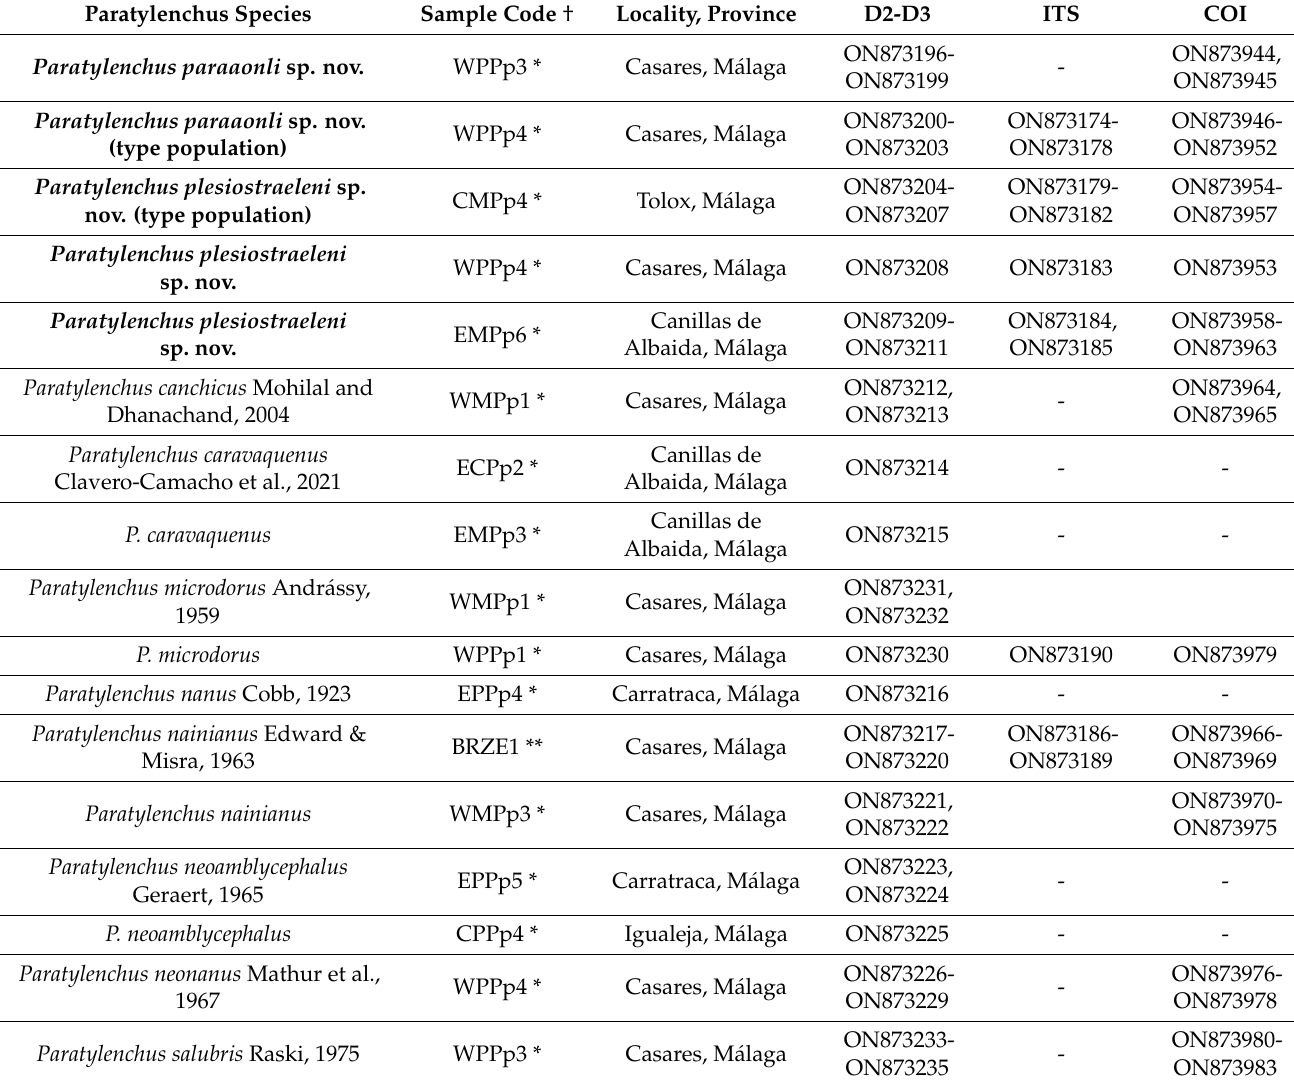
Table 1. Paratylenchus species identified in the rhizosphere of maritimus pine ( Pinus pinaster Ait.) and green heather ( Erica scoparia L.) from three mountains of the Malaga province, southern